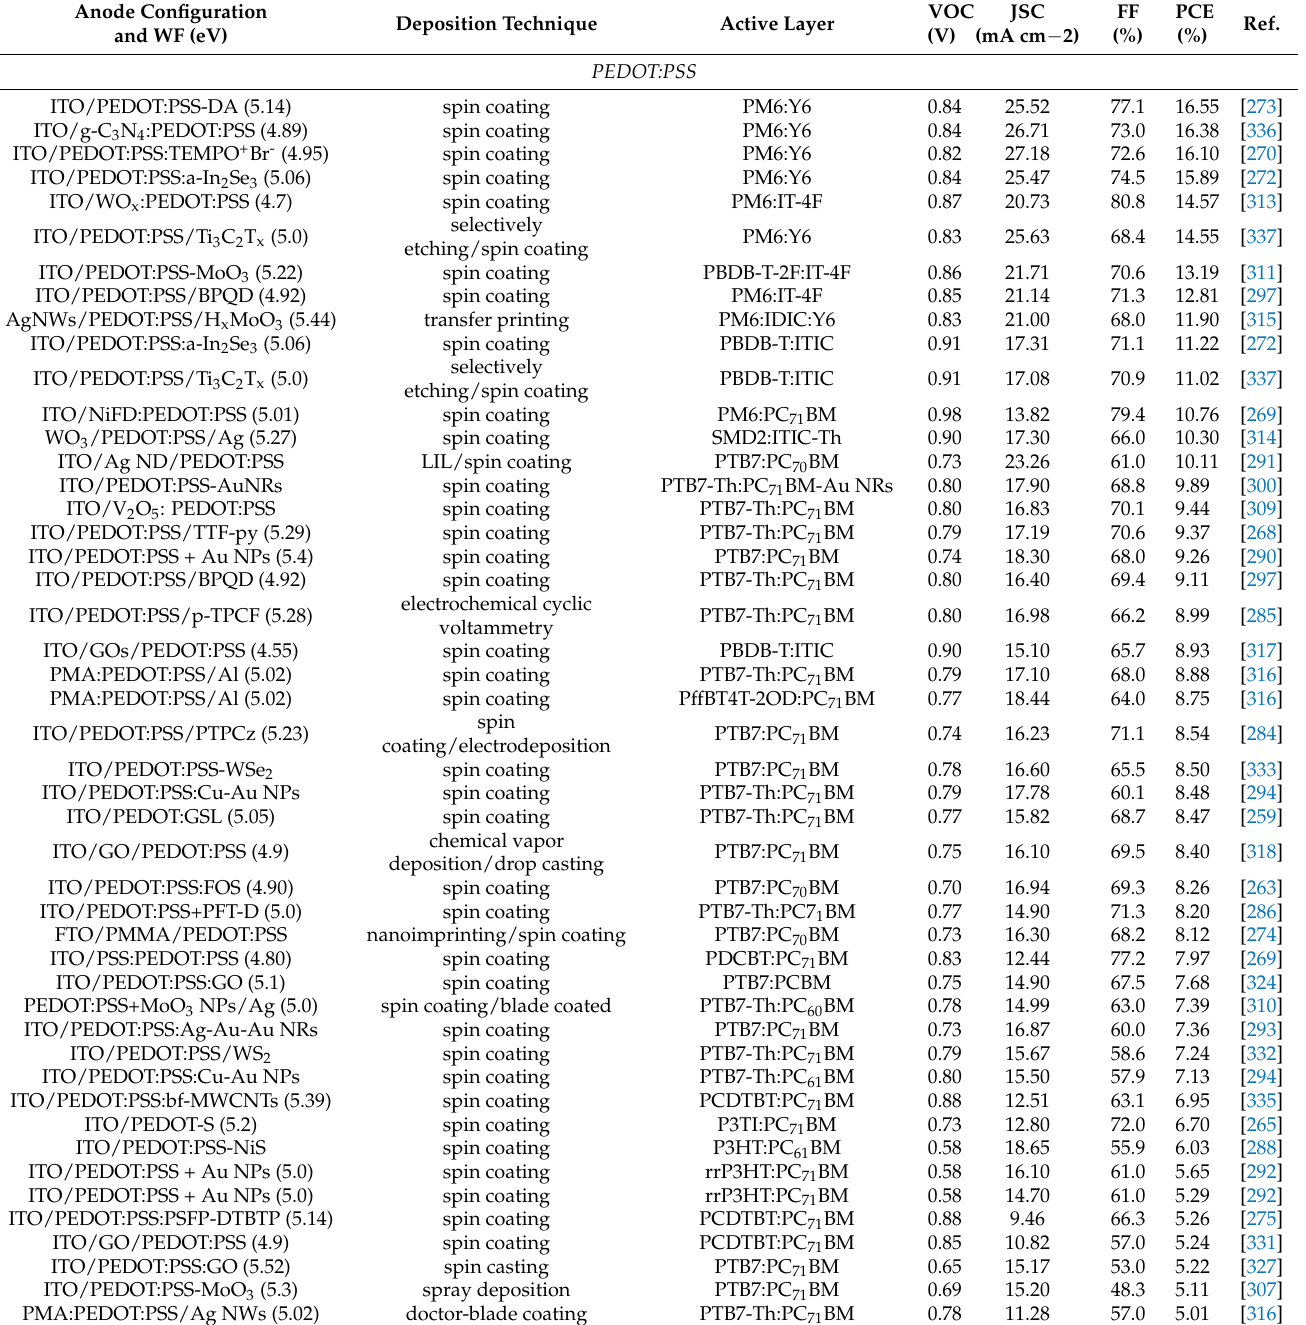
the HTL, active layer composition, and the OSCs performance parameters are provided as well as the reference where the information was taken from. Table 2. Performance parameters of some representative OSCs with different organic conjugated polymers and small molecules as